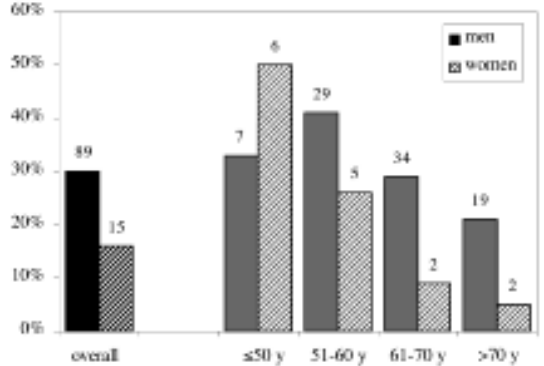
Proportion of pa- tients using Cardio- Card ® at least once during the observa- tion period: stratifica- tion by age and gender (number of patients given at the top of each